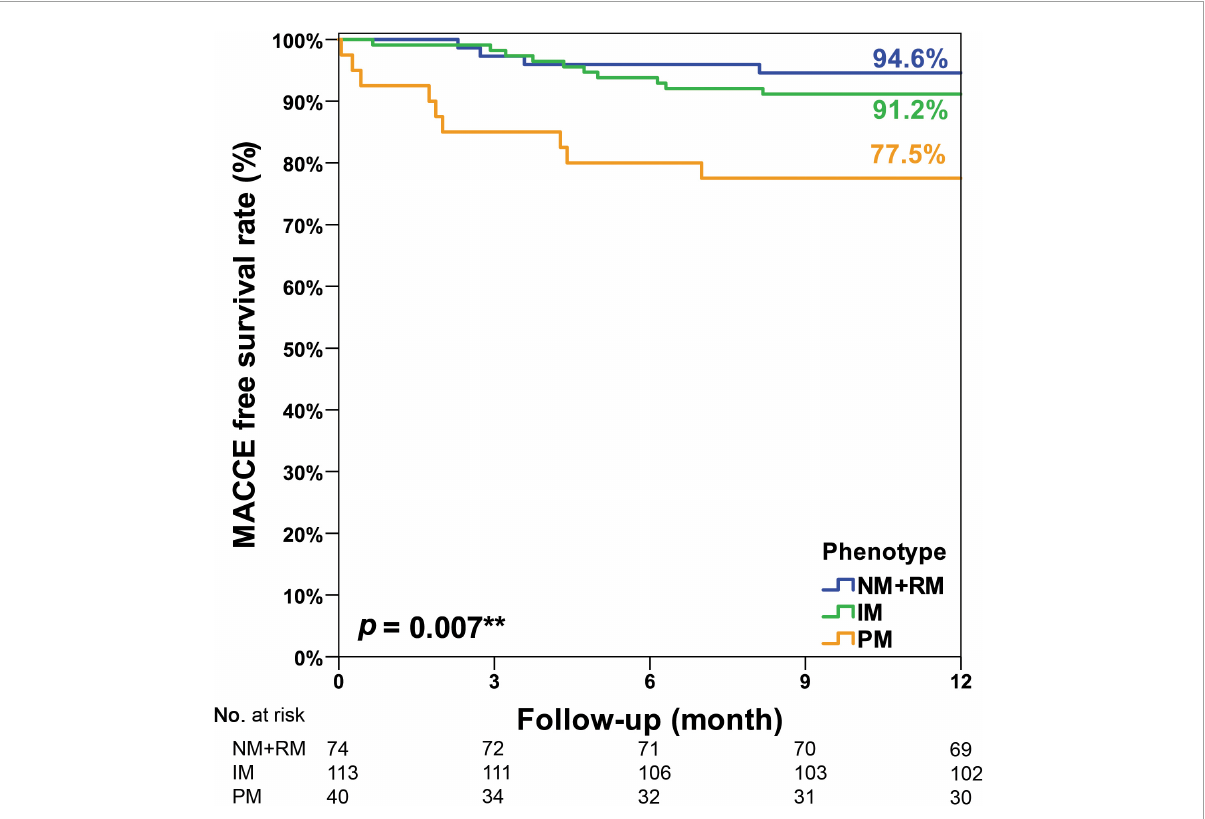
FIGURE3 Kaplan–Meier curve of the cumulative incidence of major adverse cardiovascular and cerebrovascular events (MACCE) at the 1-year follow-up stratified based on the CYP2C19 phenotype of the AMI subgroup. An unplanned post hoc pairwise multiple comparison showed that there were significantly less MACCE in the NM + RM group than in the PM group ( p = 0.005). There were significantly less MACCE in the IM group than in the PM group ( p = 0.016). However, there was no intergroup difference between the NM + RM group and the IM group ( p = 0.393). IM, intermediate metabolizer; NM, normal metabolizer; PM, poor metabolizer; RM, rapid metabolizer. **Means statistically